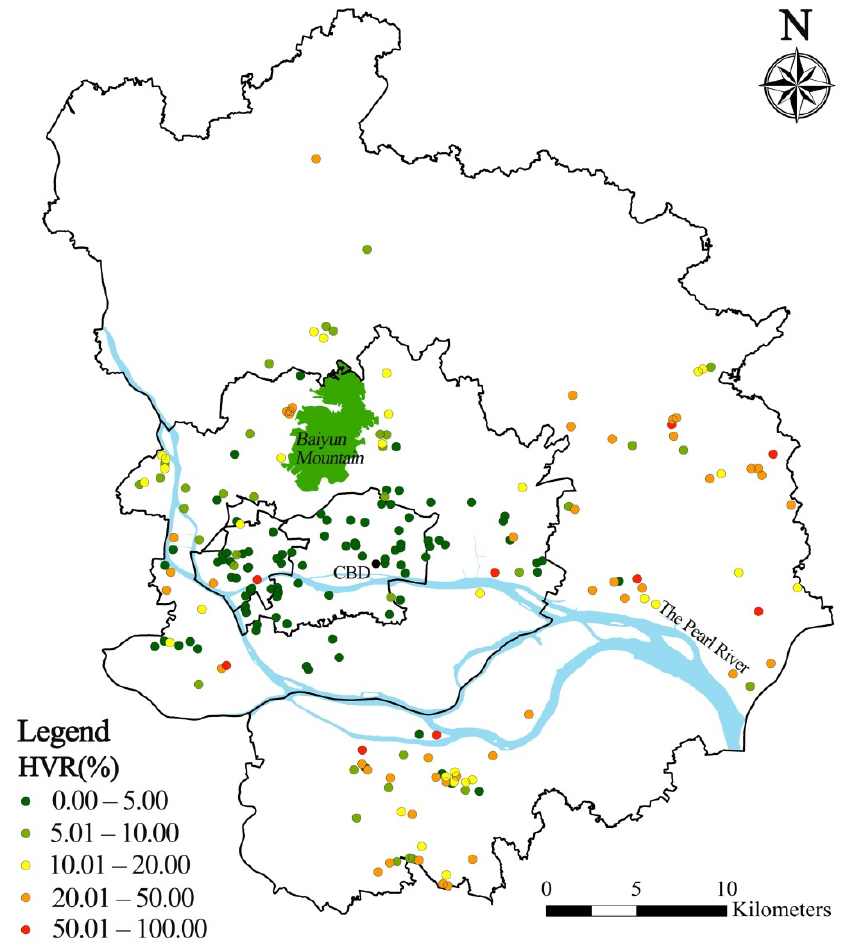
Figure 4. Spatial pattern of HVR in Guangzhou metropolitan area.